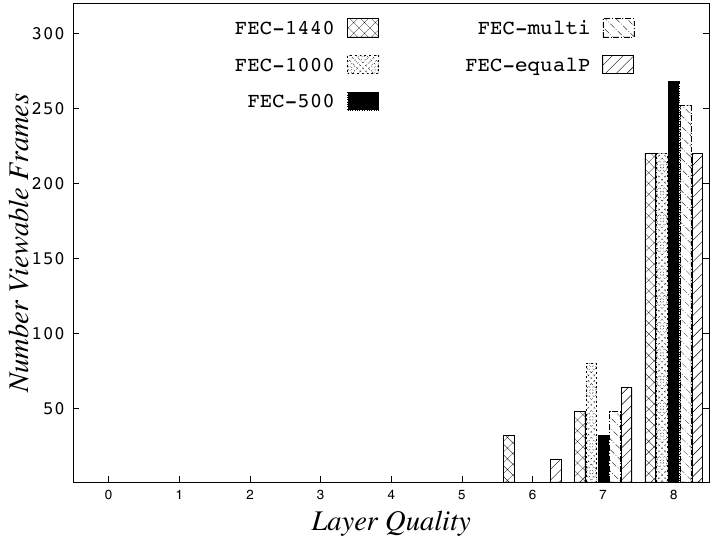
Figure A20. Example of the number of viewable layers for SVC-SC, for each of the FECPacket thres , at a packet loss rate of 10% and a GOP of 16. This image illustrates an increase in the FEC for C1 and C2 based on the worst case scenario, as shown in Table A2.